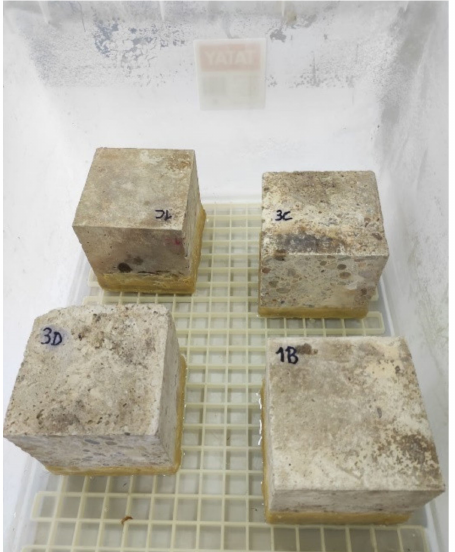
Figure 2. Concrete specimens in the capillary absorption